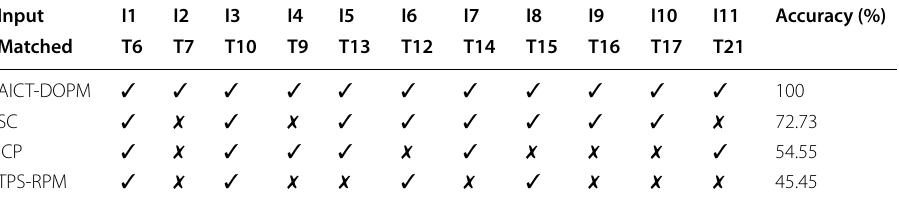
Table 1 Comparisons of object recognition for real